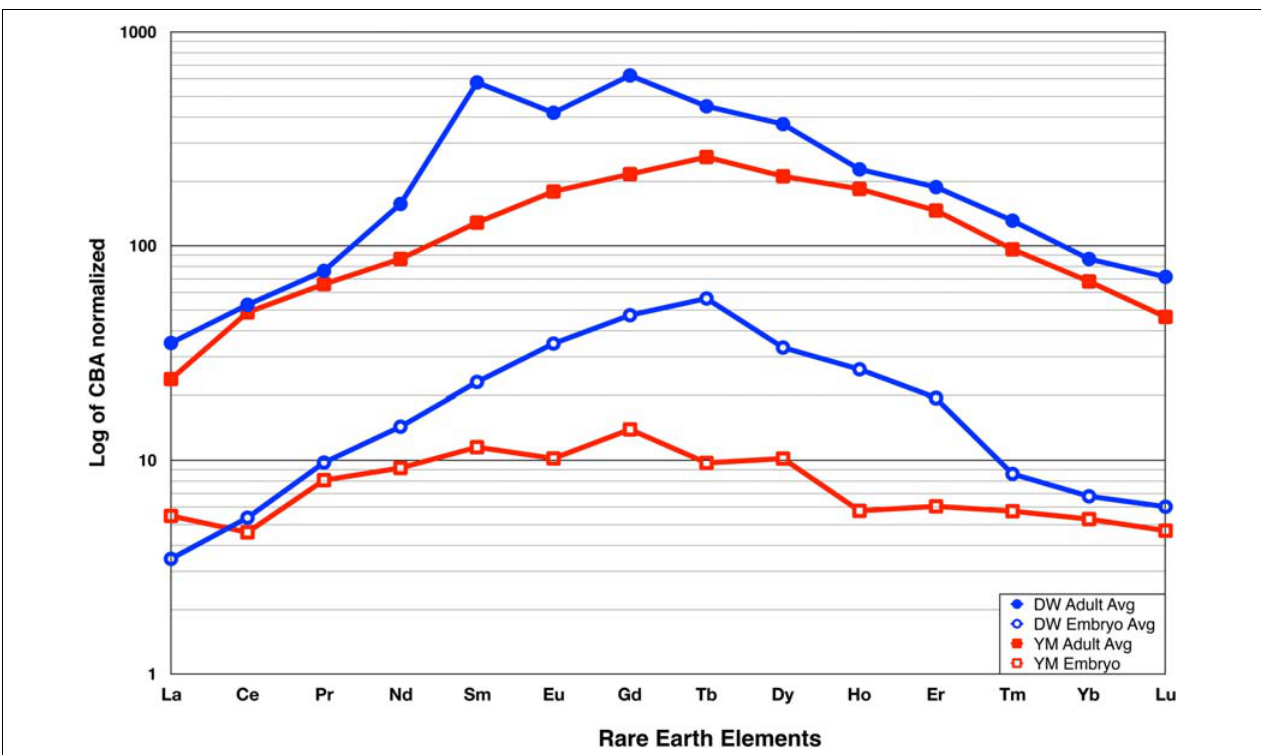
FIGURE 3 | Lanthanide Rare Earth Element (La_REE) Spidergrams of Dawa ( Lufengosaurus ) and Jiaojiadian ( Yimenosaurus ) adult and embryo femur bones. Dawa average data are shown in blue while the Jiaojiadian average data are shown in red. The La_REE concentration data is presented at ppm normalized to CBA ( y -axis) relative to the atomic number labeled as elemental symbol ( x -axis). Both dinosaur adult and embryo pairs show that the total La_REE of the adult bone is an order of magnitude higher than that of the embryo. Complete individual spidergram can be found in Supplementary Figure S3